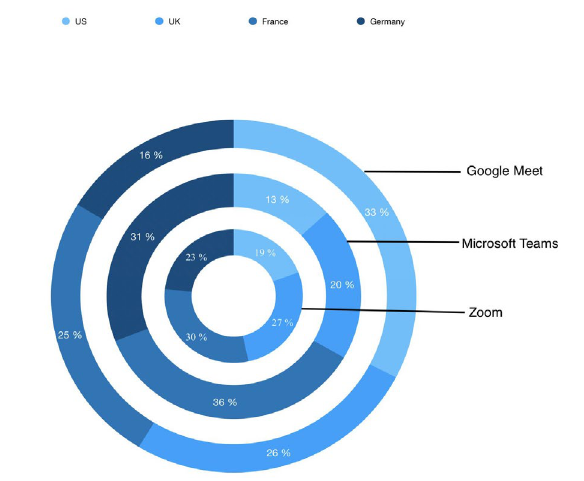
Figure 8. Percentage growth in Downloads for Google Meet, Microsoft Teams and Zoom, A Comparison of downloads during the week of March 15-21 vs the weekly average for quarter 4 of 2019.